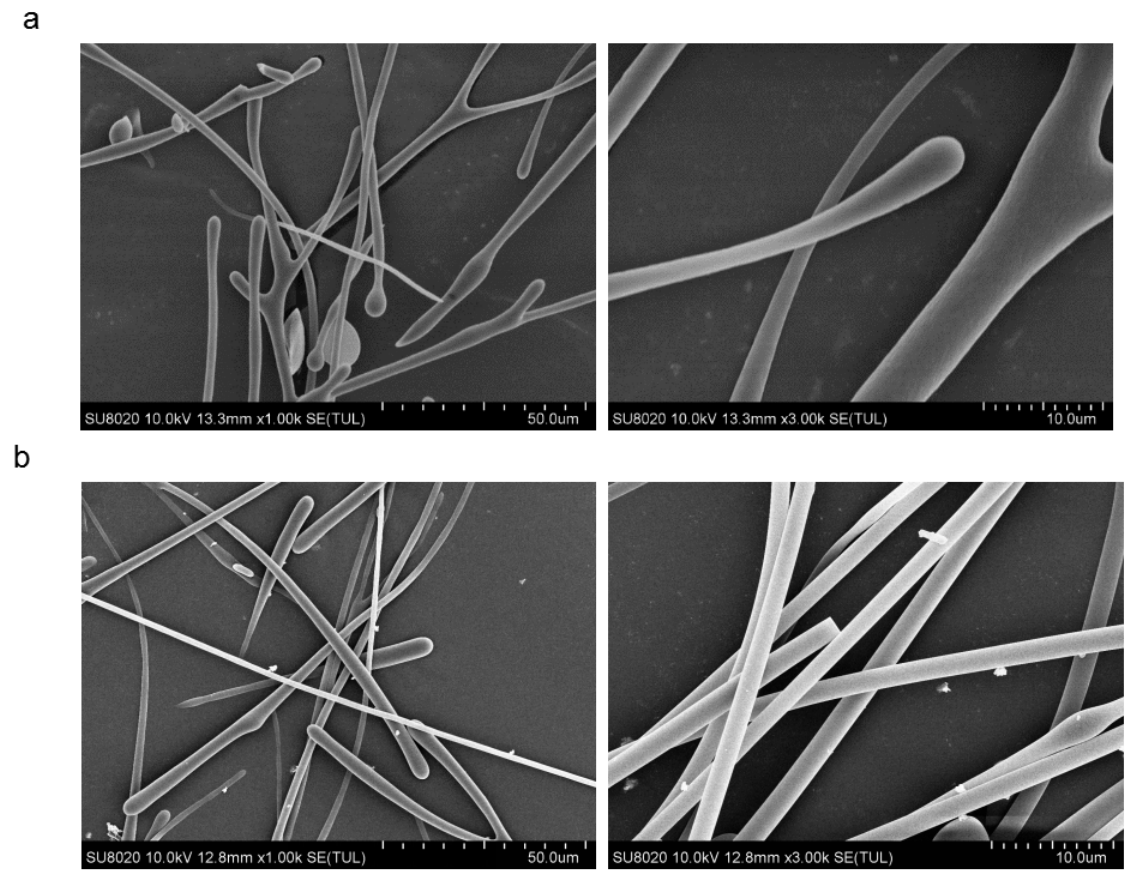
Figure 5. SEM images of 6- β -CD-N-ODMA ( a ) and PTX/6- β -CD-N-ODMA ( b ).